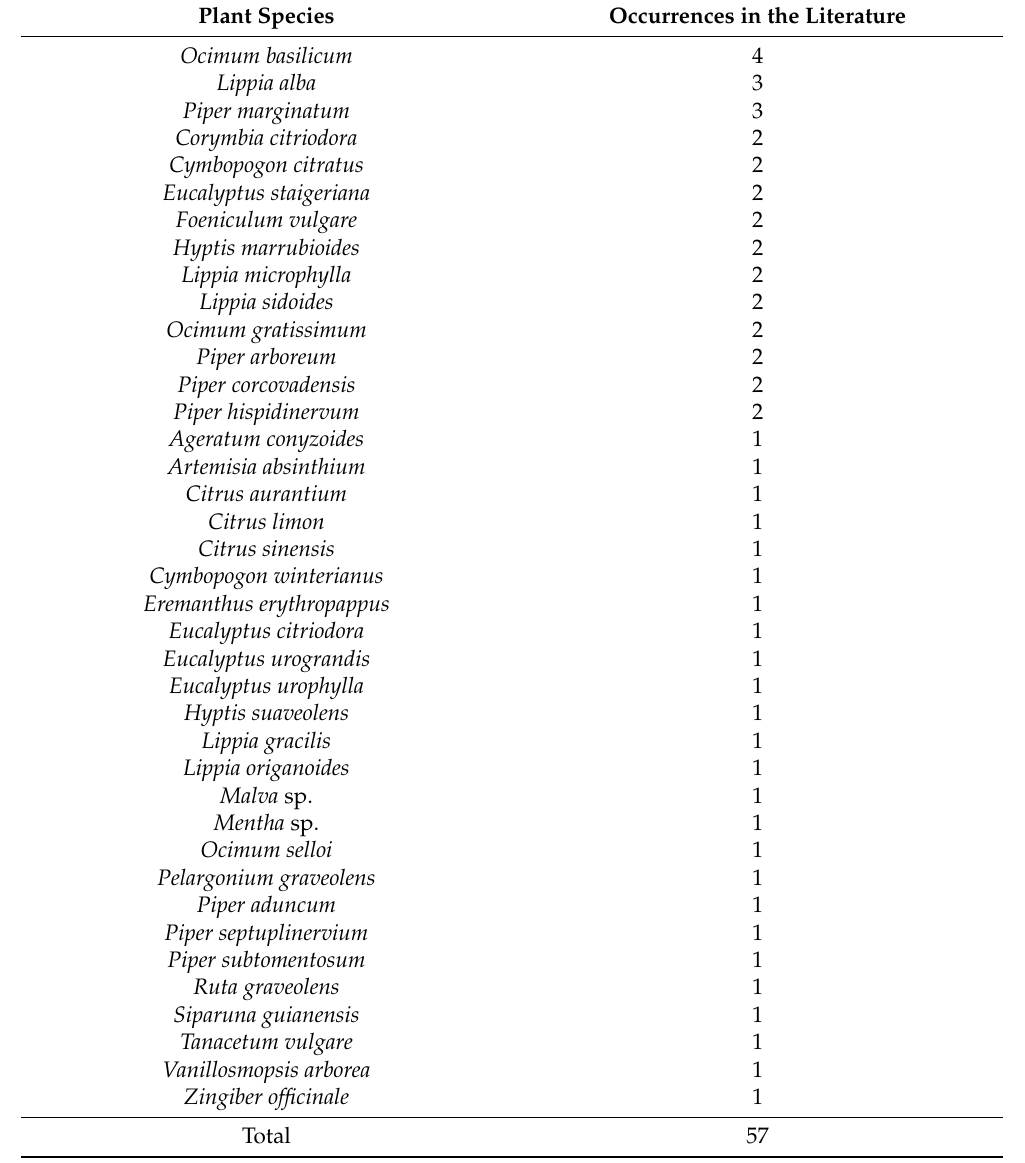
Table 3. Plant species whose essential oils are evaluated as insecticides against Spodoptera frugiperda